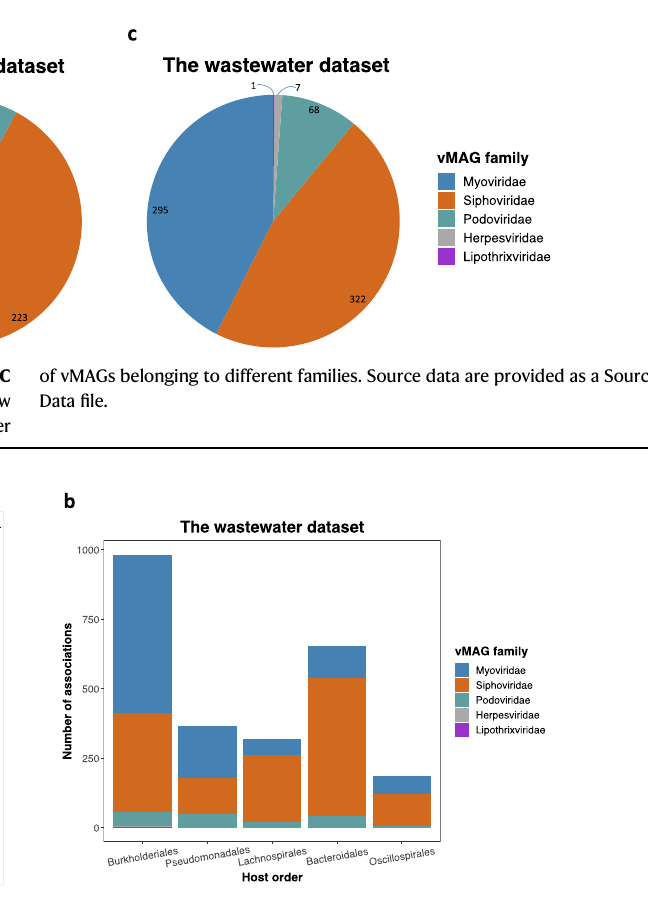
were the predominant orders in the wastewater sample. Burkholder- iales and Pseudomonadales were common orders reported in water environments 56,57 . Lachnospirales , Bacteroidales , and Oscillospirales were reported in the gut microbiomes 58 ; these are reasonable to be detected in this domestic wastewater sample from around 25,000 people 57 .